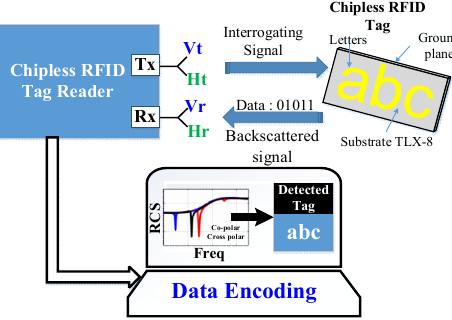
Figure 1. Working principle of the proposed methodology for the robust detection of the chipless RFID alphabet-tags.